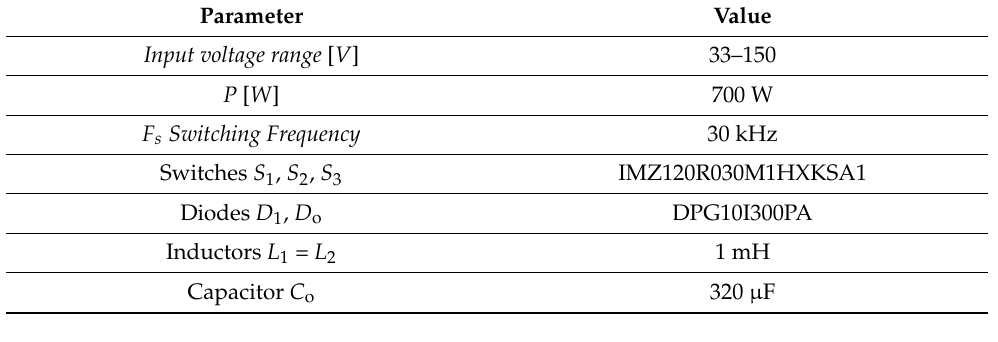
Table 2. Hardware prototype specifications.